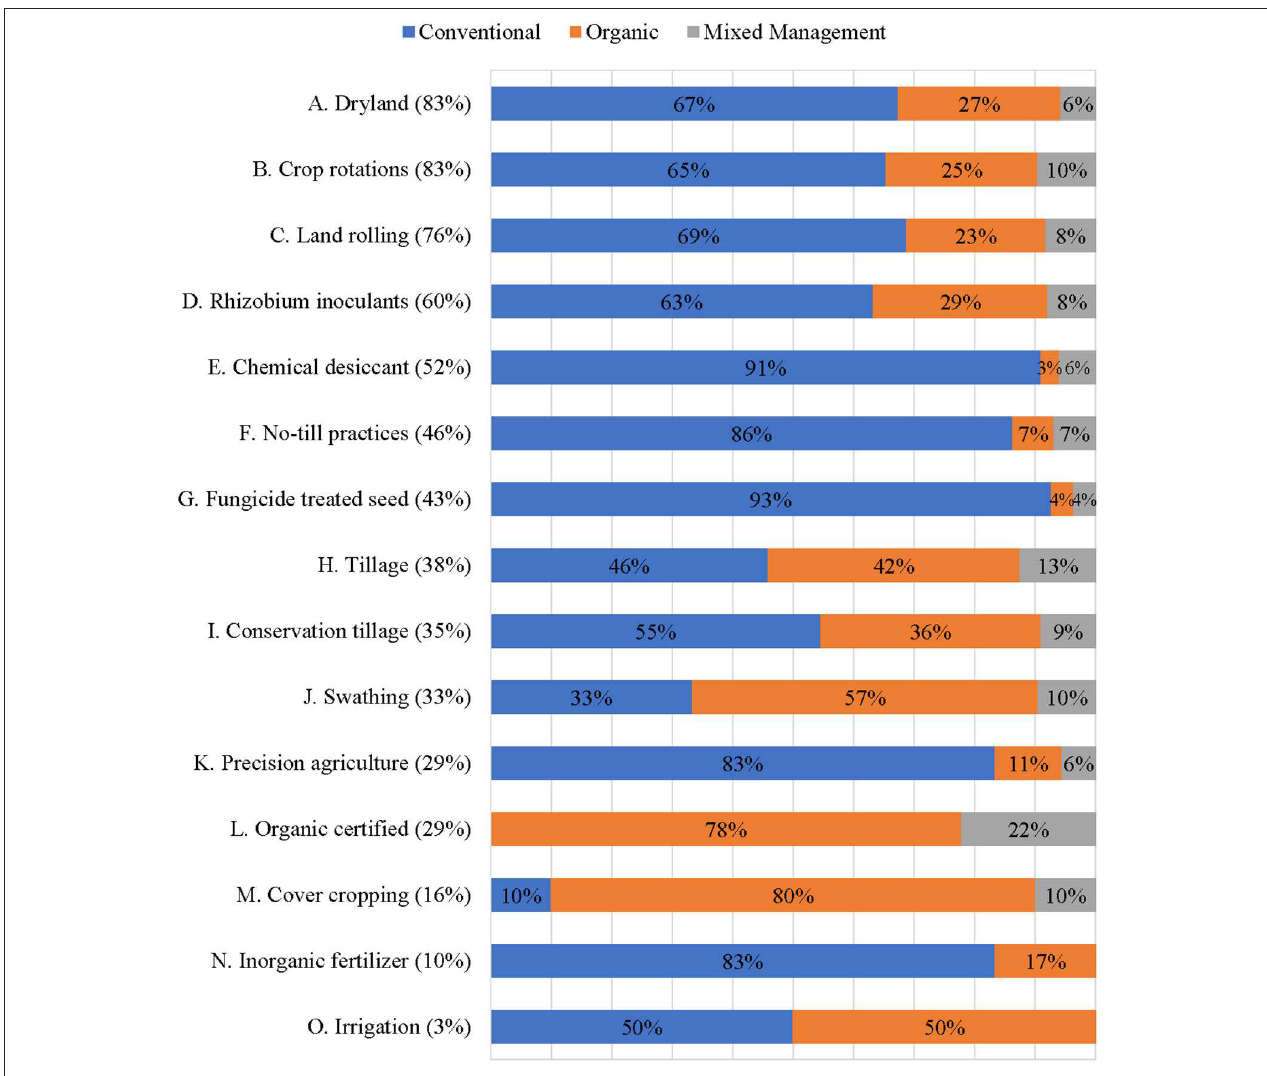
FIGURE 2 | Producers’ management practices. Total percentage (shown in parenthesis) and the proportion of conventional, organic, and mixed management producers that reported using management practices including (A) dryland farming, (B) crop rotations, (C) land rolling, (D) rhizobium inoculants, (E) chemical desiccant, (F) no-tillage, (G) fungicide treated seed, (H) tillage, (I) conservation tillage, (J) swathing, (K) precision agriculture, (L) organic certification, (M) cover cropping, (N) inorganic fertilizer, and (O) irrigation ( n =